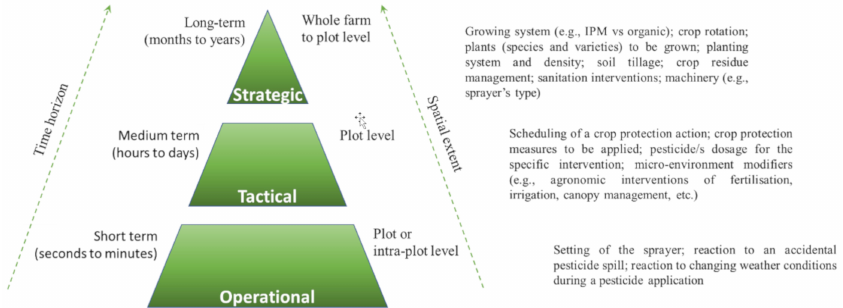
Figure 1. Relationship between the decision-making process and the type of operation in integrated pest management (IPM) at various spatio-temporal